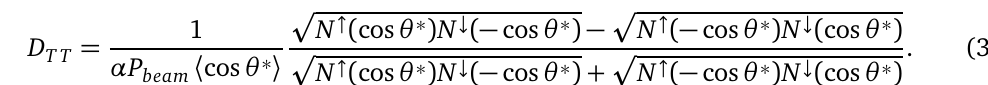
for Λ and ¯ Λ from STAR 2015 data versus hyperon p TT values for T